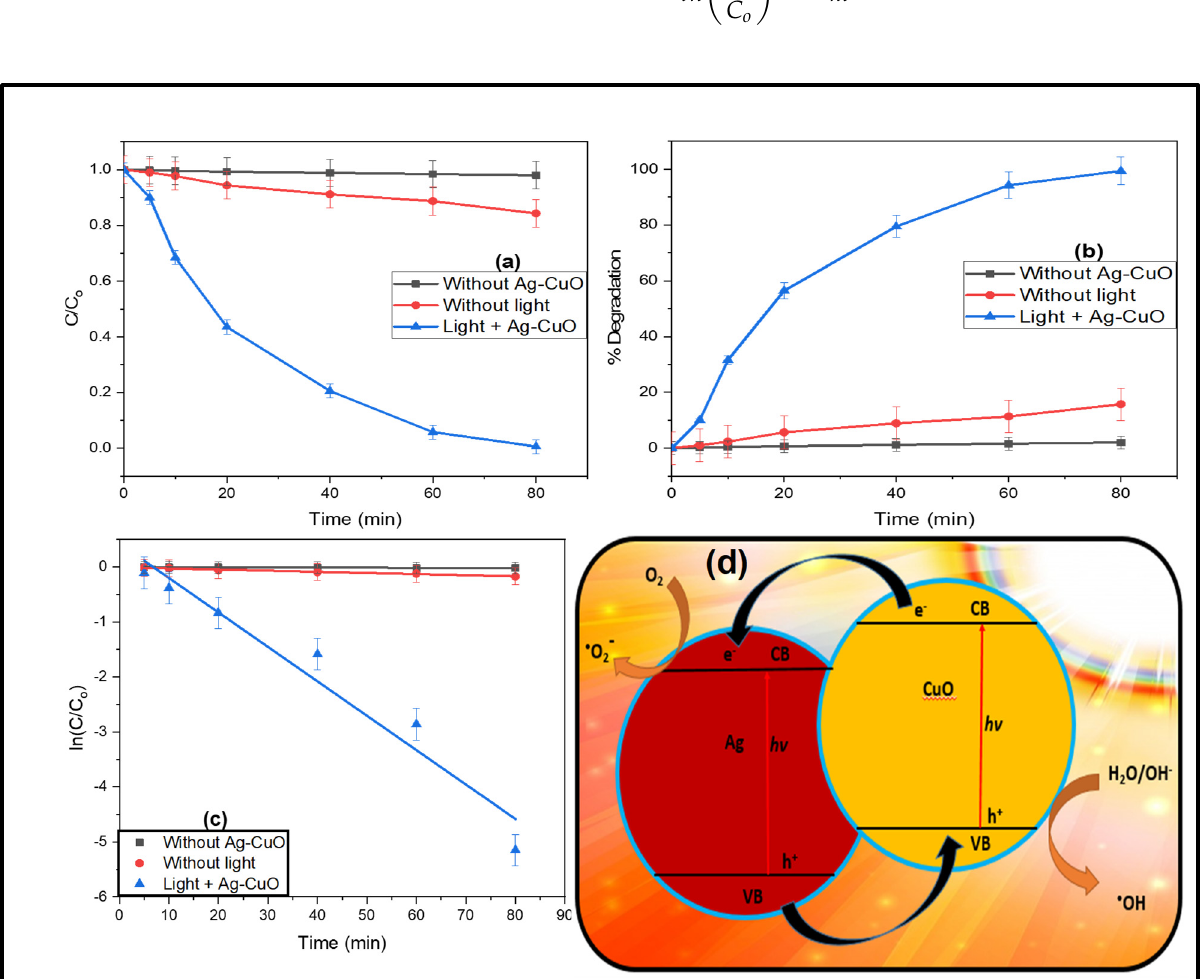
Figure 7. Photocatalytic experiment parameters: ( a ) degradation profile, ( b ) percentage degradation profile, ( c ) kinetic isotherm, and ( d ) electron excitation and hole creation mechanism. Table 1. Comparison of the photocatalytic efficacy of different nanocatalysts against rhodamine 6G. S.No.